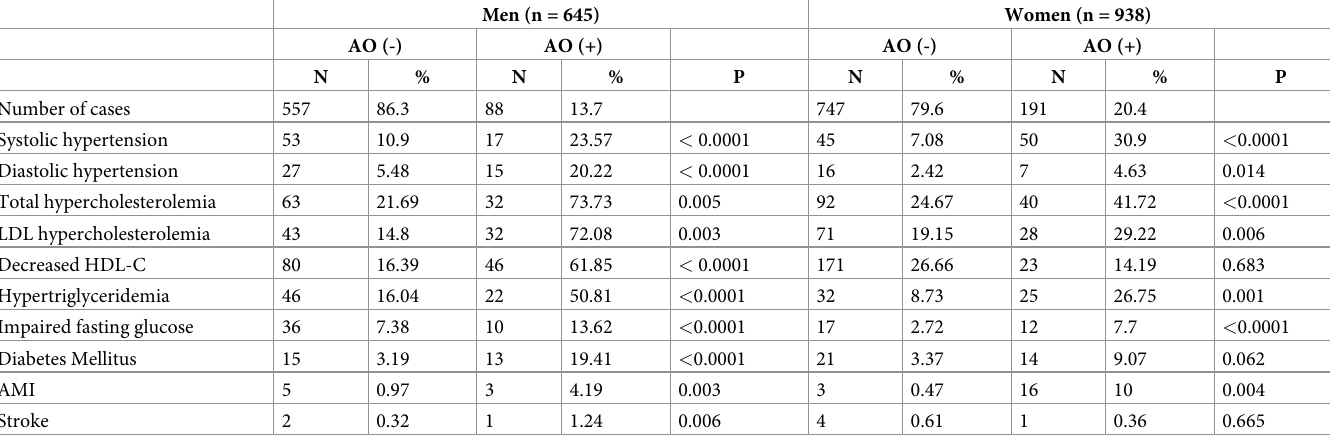
Table 5. Frequency of CVRF, AMI and stroke in normal weight individuals (BMI:18.5–24.99 kg/m 2 ) with AO defined by lower WC cutoff values.